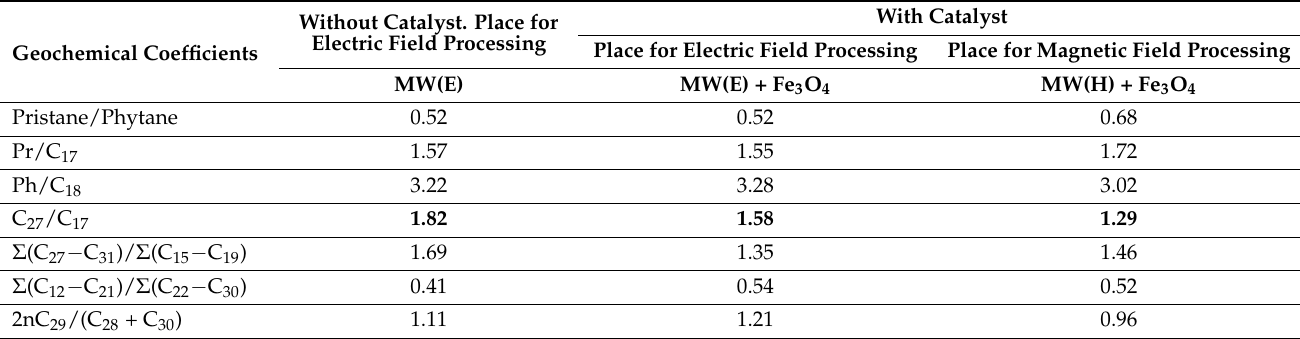
Table 2. Geochemical coefficients of the studied oil samples after experiments.